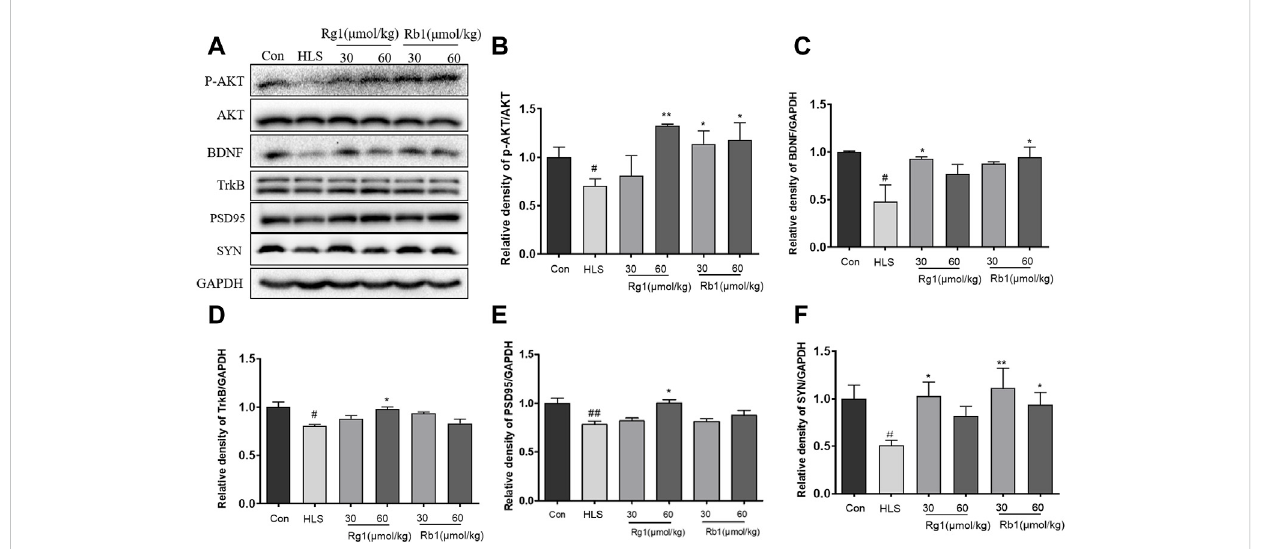
FIGURE 5 Ginsenosides Rg1 and Rb1 in fl uence the expression of BDNF signaling pathway-related proteins in hindlimb suspension (HLS) rats. (A – F) Protein bandsandrelativeexpressionlevelsofp-Akt/AKT,TrkB,BDNF,PSD-95,andSYNinthePFC.Datarepresentmeans±SEM; N =4ratspergroup. # p < 0.05, ## p < 0.01, signi fi cantly different from control; * p < 0.05, ** p < 0.01, signi fi cantly different from HLS